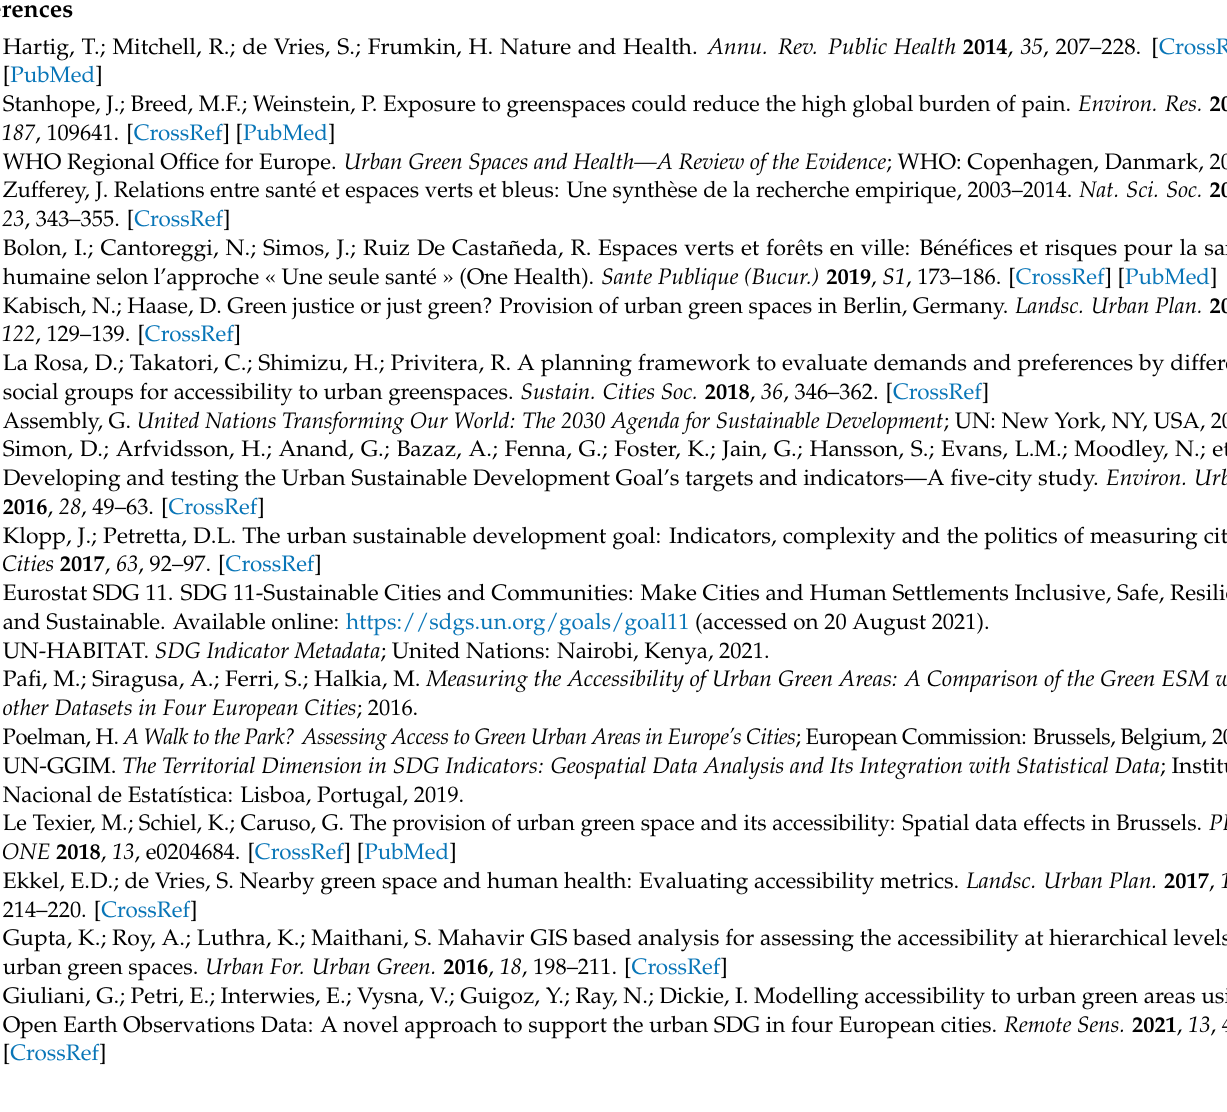
Table S3: Percentage of population that have access to UGS within a maximum travel time, using ArcGIS cost-distance analysis in isotropic mode, Figure S1: Percentage of the population per Canton that have access to the centroid of the nearest Urban Green